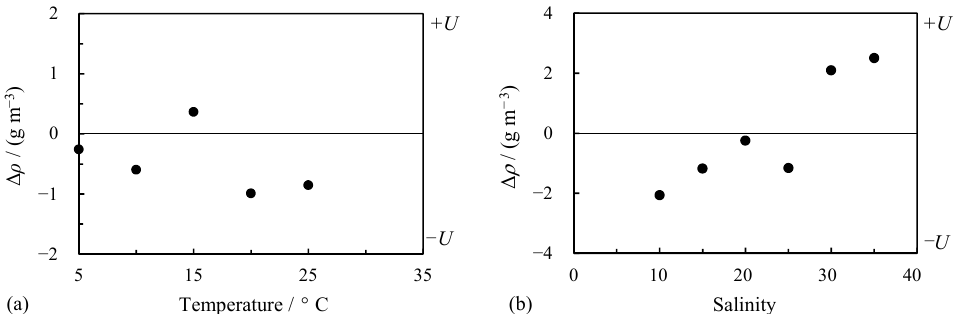
Figure 7. Deviation of measured from predicted seawater densities (cid:49)ρ . (a) In the interpolation region at salinity 2 and (b) in the extrapolation region at 1 ◦ C and atmospheric pressure, respectively. U – uncertainty in the density–salinity